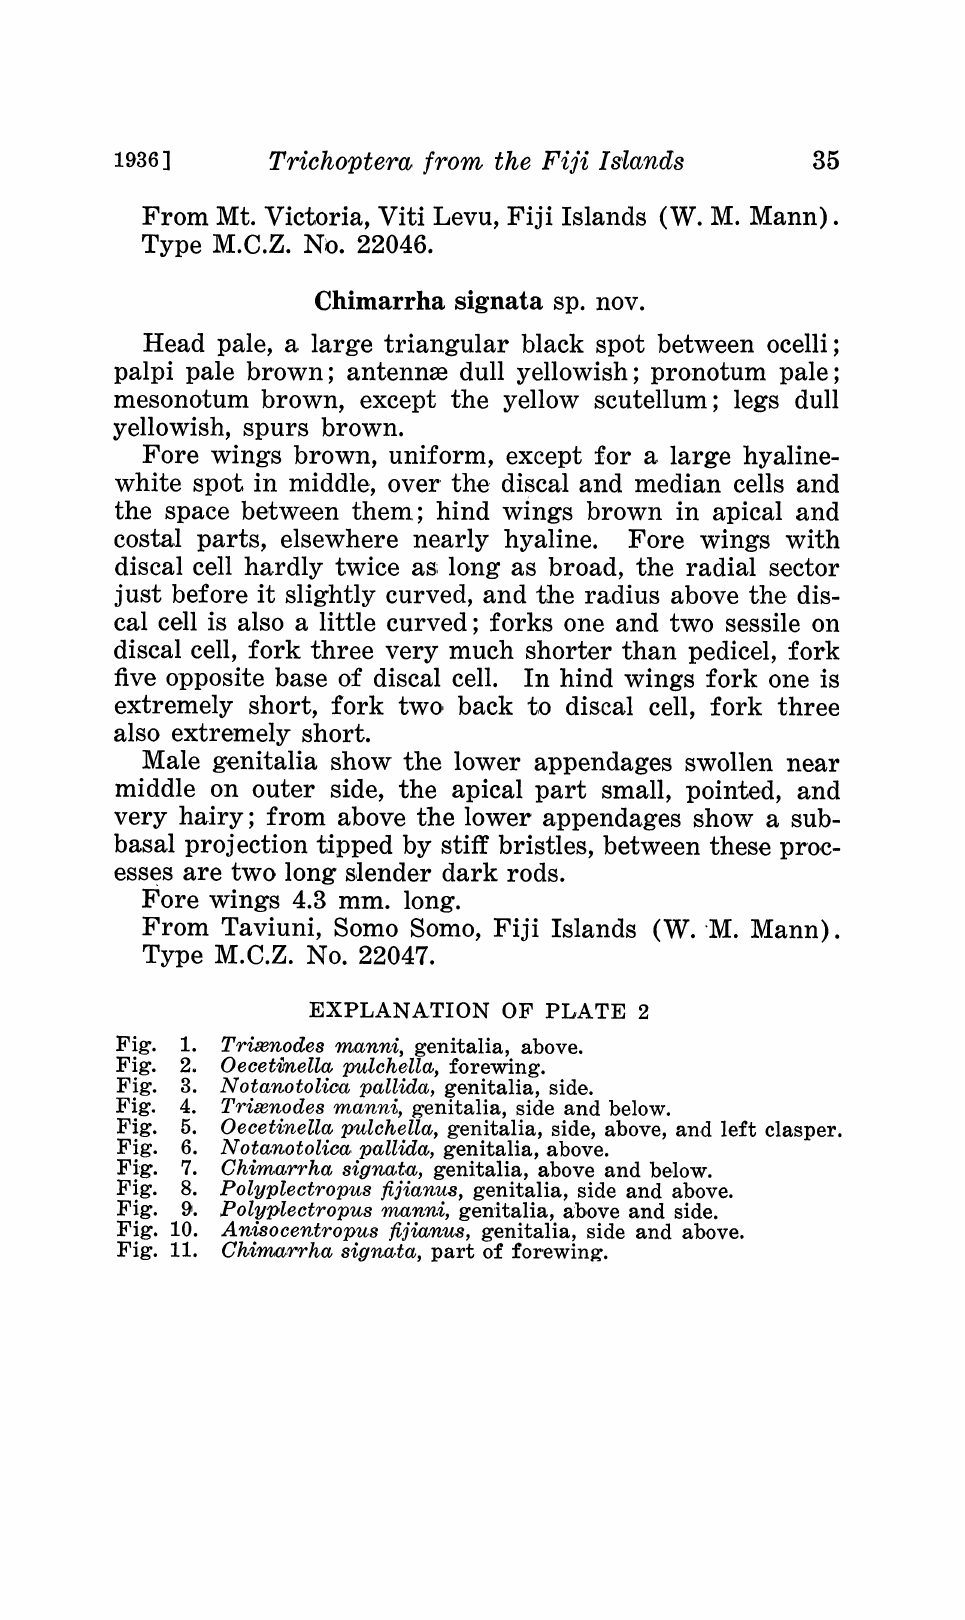
EXPLANA.TION OF PLATE 2 Trixnodes m.anni, genitalia, above. Oecetinella pulchella, forewing. Notanotolic,a pallida, genitalia, side. Trixnodes manni, genitalia, side and below. Oecetinella pulchella, genitalia, side, above, and left clasper. Notnotoliva. pallid, genitalia, above. Chimarrha signct.a, genitalia, above and below. Polyplectropus fi]ianus, genitalia, side and above. Polyplectropus manni, genitalia, above and side. Anisocentropus fi]inus, genitalia, side and above. Ckia.rrha signata, part of Fig. 11.